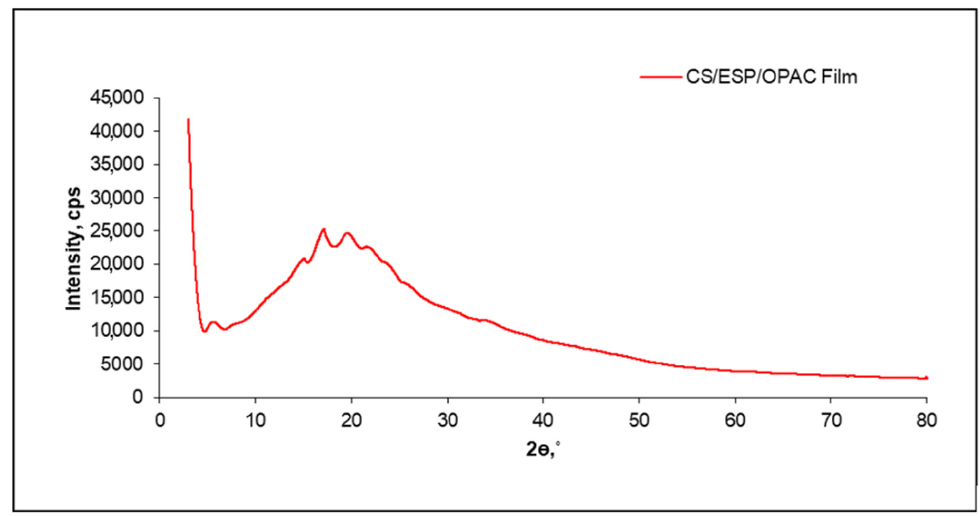
Figure 3. XRD diffraction patterns of CS/ESP/OPAC film.